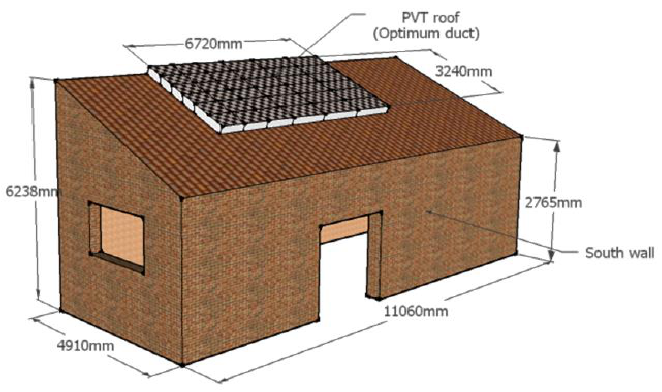
Figure 1. Perspective view of proposed building integrated photovoltaic thermal (BIPVT) system installed at the roof of the building